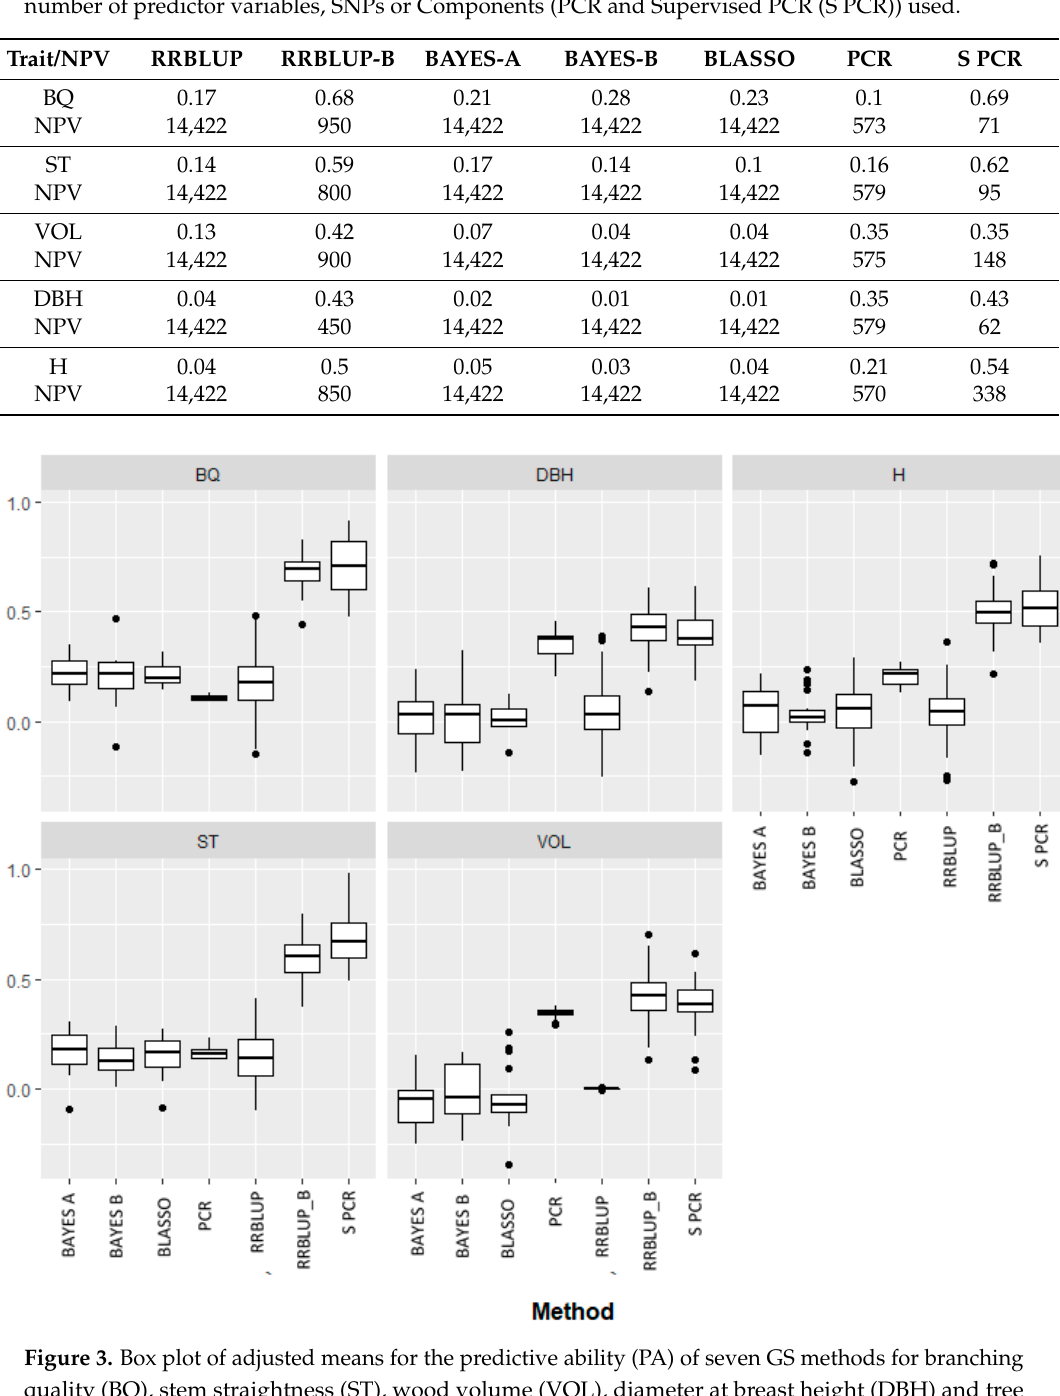
Table 4. Predictive ability of seven prediction methods (with cross ‐ validation) for branching quality (BQ), stem straightness (ST), wood volume (VOL), diameter at breast height (DBH) and tree height (H) in Eucalyptus globulus families, evaluated under oceanic climate conditions. NPV corresponds to